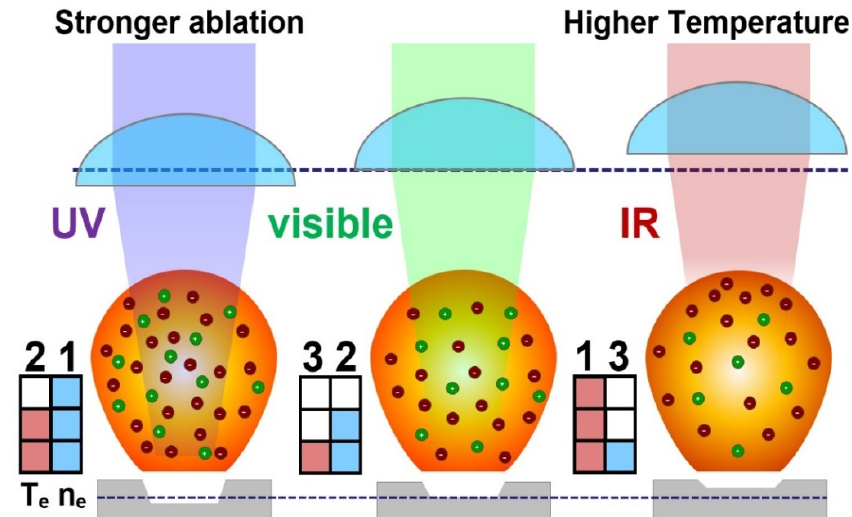
Figure 9. Schematic of the change in the laser ablation process of the monazite sample using a UV (266 nm), visible (532 nm) and IR (1064 nm) laser with the same laser energy and spot size. The dark red dots ( − ) in the schematic plasma plume show electrons, while the green dots (+) show ions. The red colored column in the matrix shows T e and the blue color shows n e .